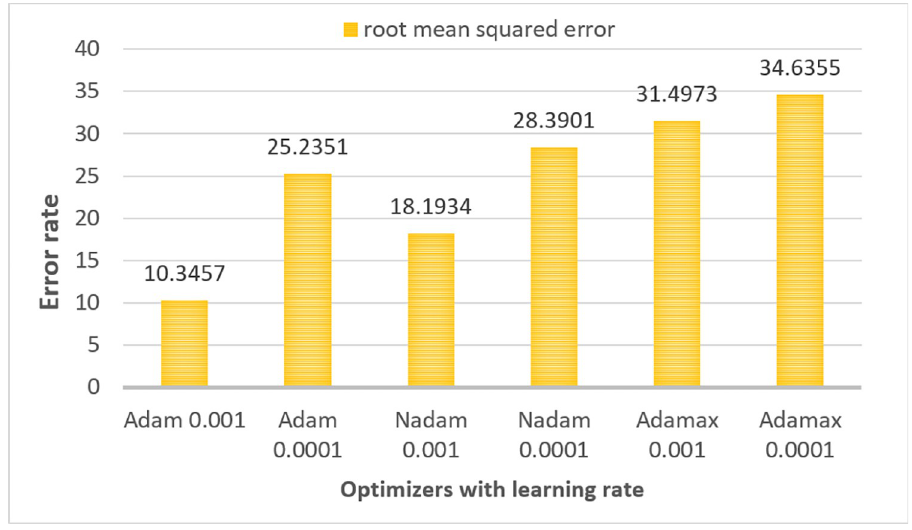
Fig 22. Root mean squared error of all six configurations of SCNN_12.